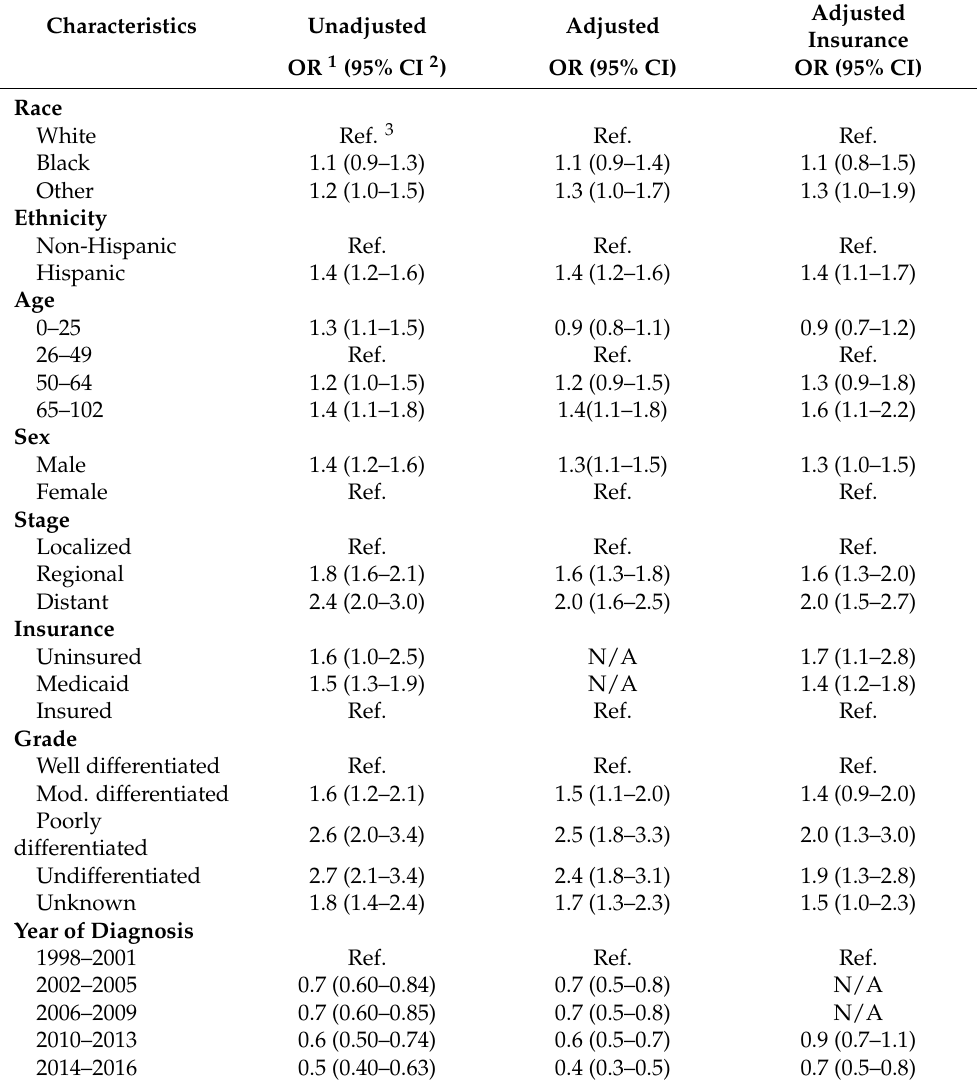
Table 2. Unadjusted and adjusted associations between participant characteristics and odds of amputation.